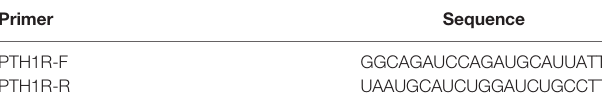
TABLE 1 | siRNA sequences of